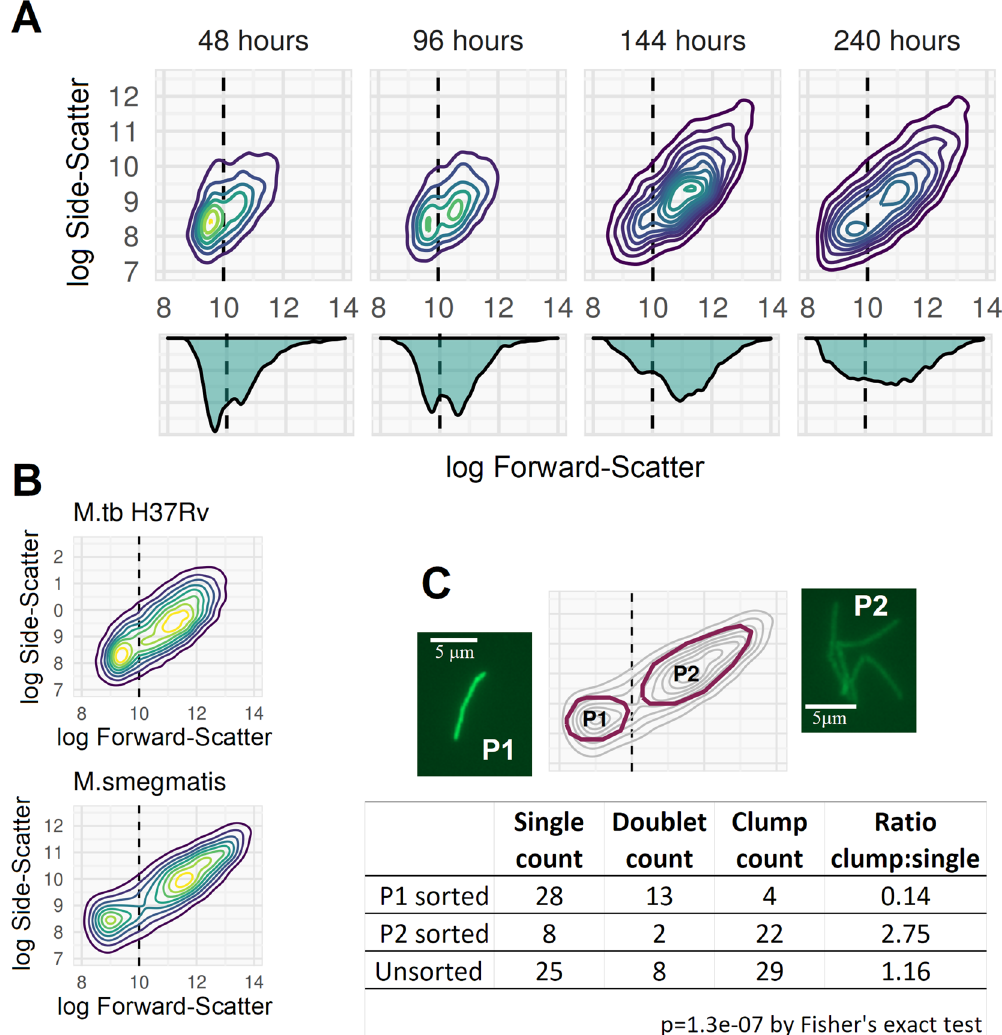
Figure 2. Identifying mycobacterial clumping with FCM. ( A ) 2D-density plots of FSC v SSC on log scale for a culture of M. bovis BCG grown with 0.15% v/v Tween80 at 180 rpm. Plots are from samples taken at 48, 96, 144, and 240 h after bacilli were sub-cultured from a log-phase starter culture into pre-warmed broth (early, early- mid, late-mid and late log-phase, respectively). Samples were diluted tenfold or 100-fold (later samples) in 0.25% v/v Tween80 PBS and sonicated for 60 s prior to flow cytometry. The tail of higher SSC and FSC events at 48-h is seen to develop into a discrete second subpopulation by 96-h, which continues to expand into a higher SSC and FSC region and become the predominant subpopulation by the end of log-phase. All plots are constructed from 5000 events. ( B ) M. tuberculosis and M. smegmatis processed as above (both mid-late log phase) also develop dual populations separating on FSC and SSC, replicating the M. bovis BCG findings. ( C ) M. smegmatis sample was run on a BioRad S3 cell sorter with P1 and P2 sorted for downstream fluorescence microscopy (representative images shown). M. smegmatis was used for cell sorting owing to concerns about aerosolising M. tuberculosis or M. bovis BCG. P1 comprised majority single cells or doublets, while P2 comprised majority clumps (manually quantified from fluorescence microscopy